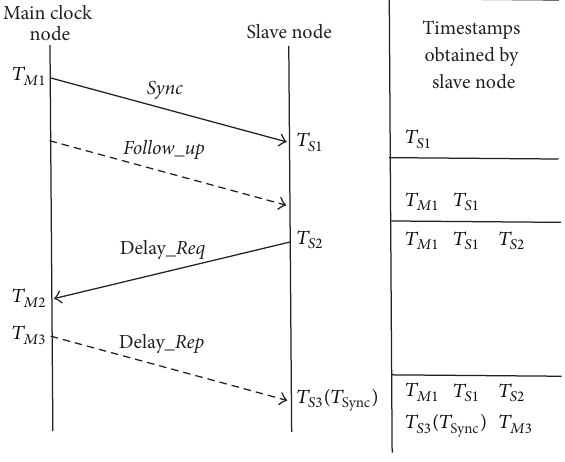
Figure 2: CSP without